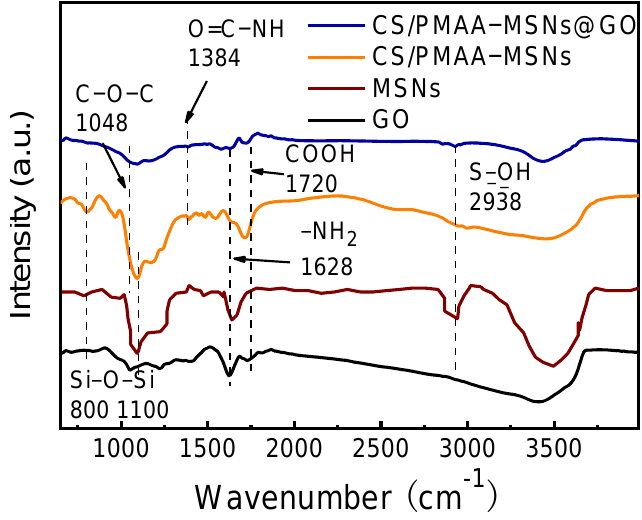
Figure 6. FT − IR spectra of GO, MSNs, and CS/PMAA-MSNs.